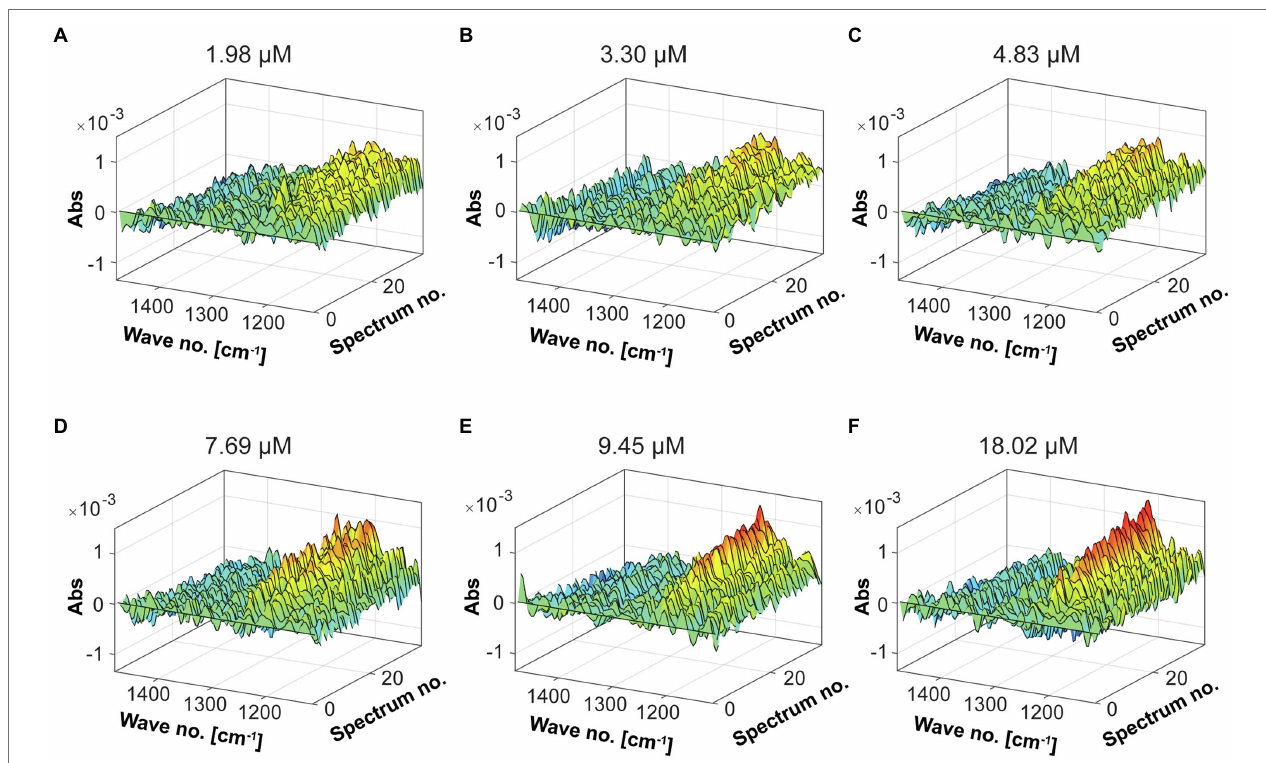
FIGURE 11 | FTIR spectral evolution profiles for the Fhf2 Δ 484 endo-fucoidanase. The spectral evolution changes (30 spectra) in response to the enzyme concentration. The background spectra of buffer and substrate were subtracted. 2% w/v of fucoidans from F. evanescens was used at increasing enzyme